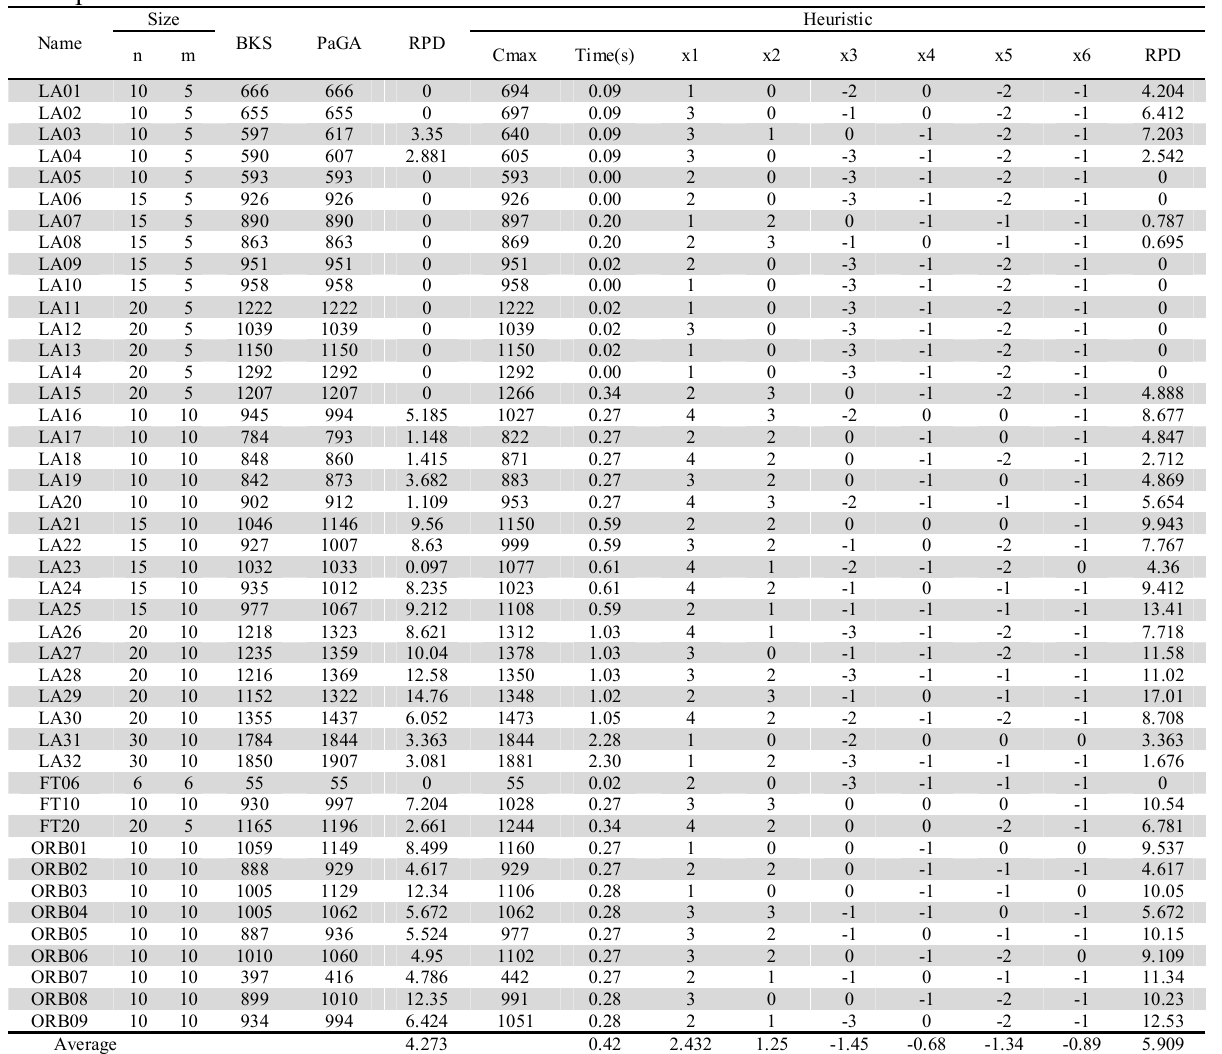
Computational results for benchmark